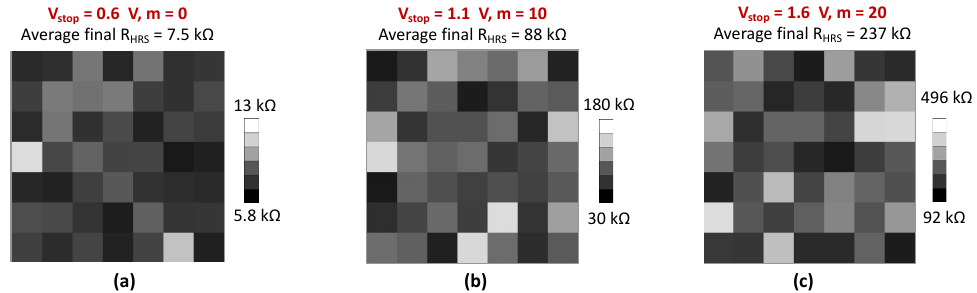
Figure 8. R HRS bitmaps extraction after RST 2 operation for 3 different V stop values: ( a ) V stop = 0.6 V; ( b ) V stop = 1.1 V et; ( c ) V stop = 1.6 V.